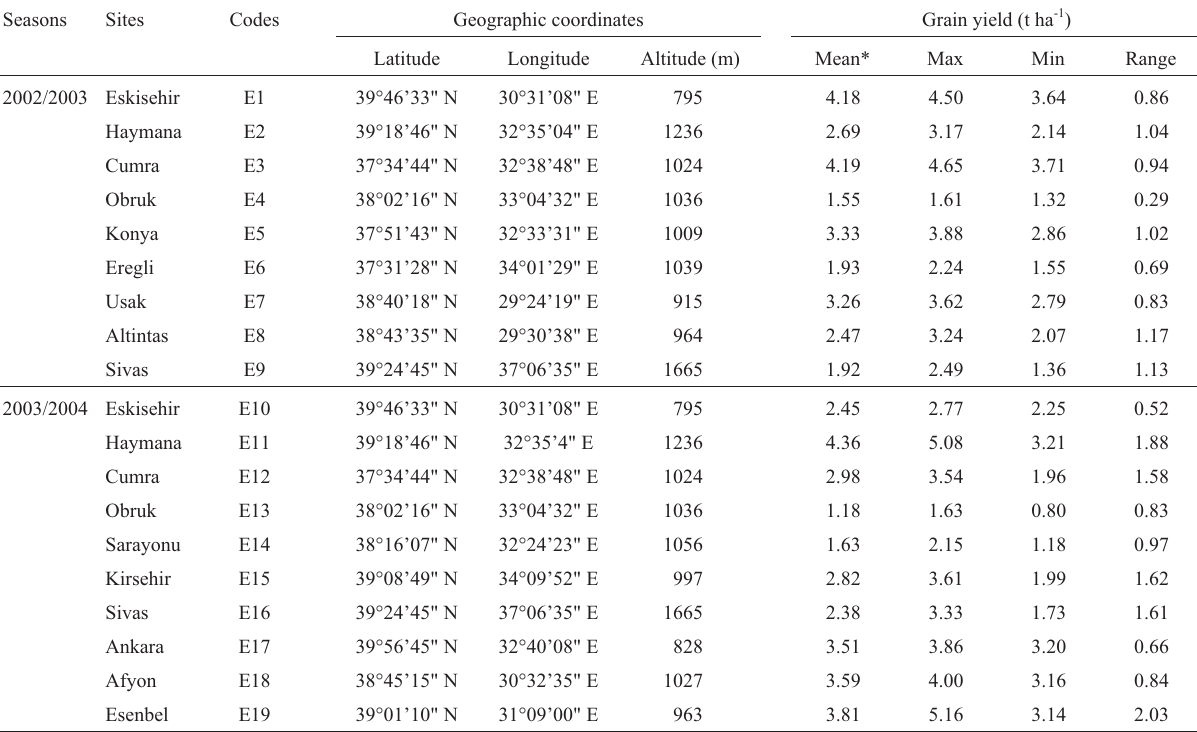
Table 2 - Growing seasons, environments and grain yield for bread wheat genotypes growing at different sites in Turkey. Seasons